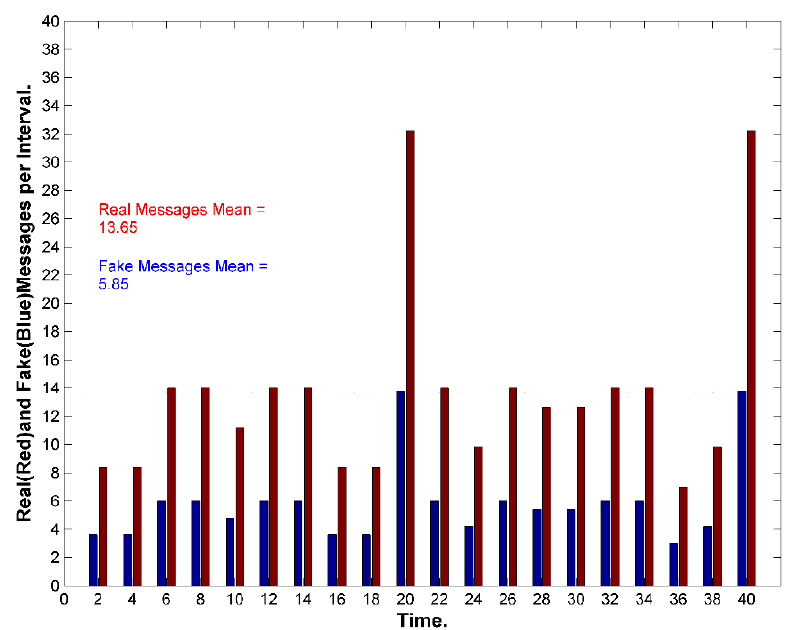
Figure 26. The average fake messages in a busy network with 70% of the slots occupied by real messages. The reduction of fake messages transmission in ECAT is about 88% compared to